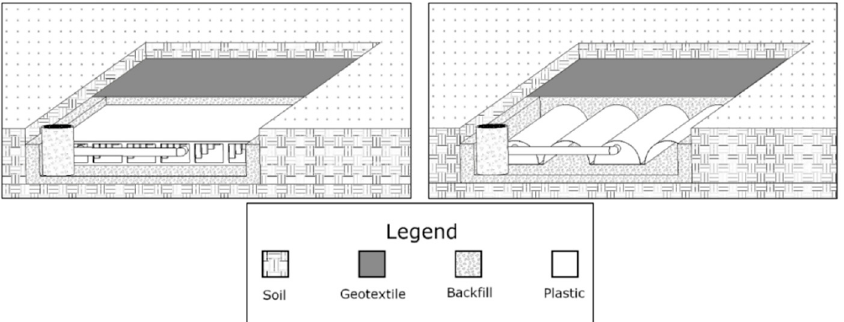
Figure 1. Example of single-layer recharge chamber structure installation with cutaway views, showing undisturbed soil, geotextile fabric, backfill material, and plastic box ( left view ) and arch ( right view ).